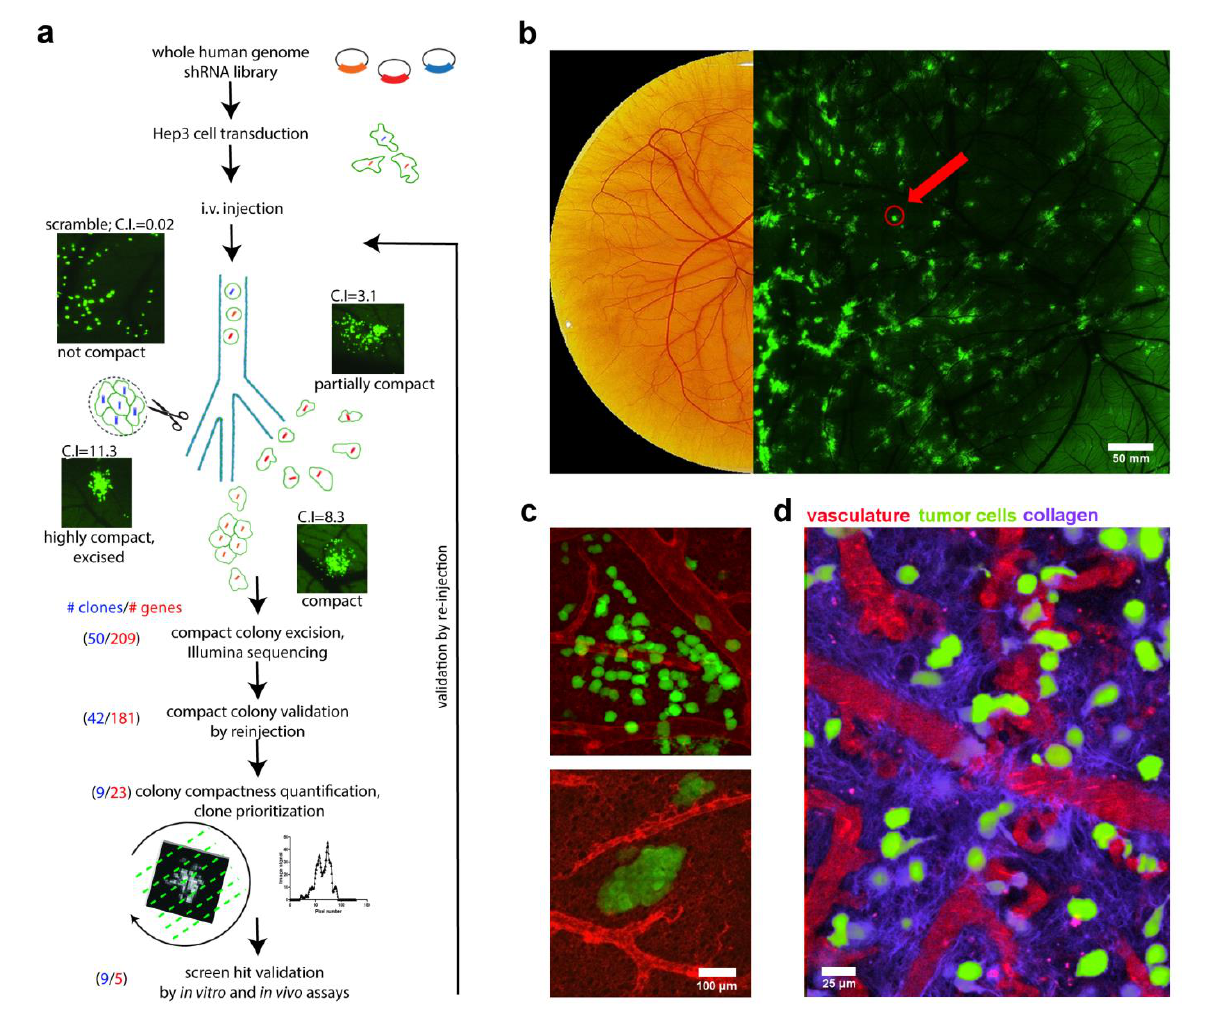
FIGURE 1: Chicken embryo as a platform for anti-metastatic target discovery. (a) Overview of intravital shRNA screen for drivers of hu- man cancer metastasis. (b) Chicken CAM, fifteen days post fertilization. Left image shows brightfield view, right image shows a low- magnification, fluorescence image of GFP-expressing metastatic cancer cell colonies within the CAM tissue. Red arrow points to compact metastatic cancer cell colony. (c) High-resolution images of invasive (upper) and compact (lower) metastatic cancer cell colonies (green) and their associated vasculature (red) within the chicken CAM tissue. (d) Intravital imaging of cancer cells (green) and their interaction with vasculature (red) and the collagen matrix (purple) within the chicken CAM tissue. Collagen was visualized using second harmonic generation (SHG)